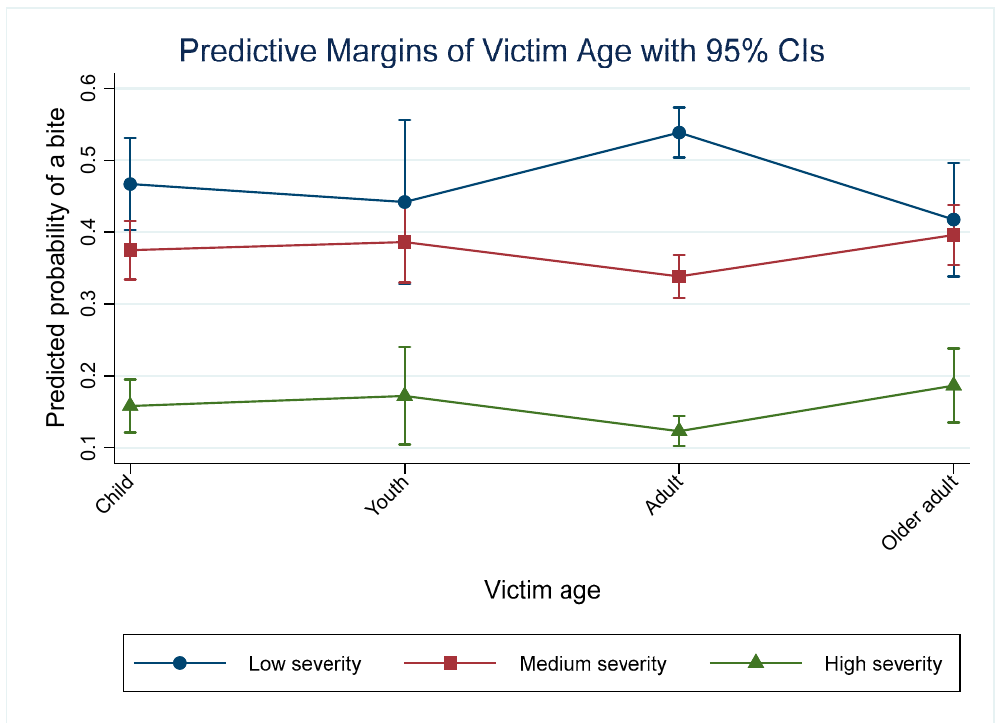
Figure 4. Predictive margins for the different level of dog chase/bite incidents depending on the victim age category and controlling for other variables in the model.